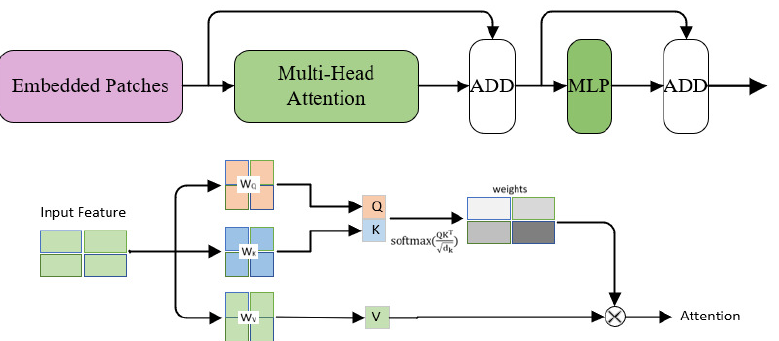
Figure 2. Trans module, above is the overall process, below is the Attention calculation